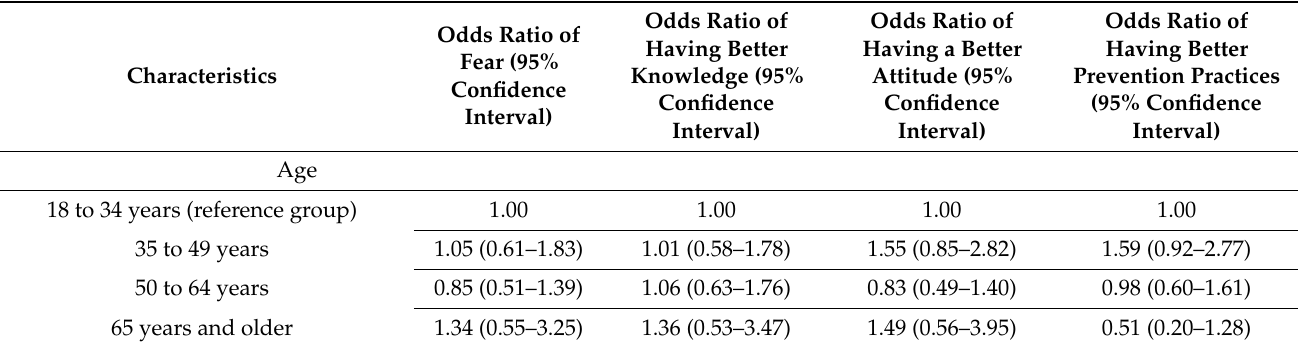
Table 8. Predictors of patients’ perceived fear and knowledge, attitude, and prevention practices toward